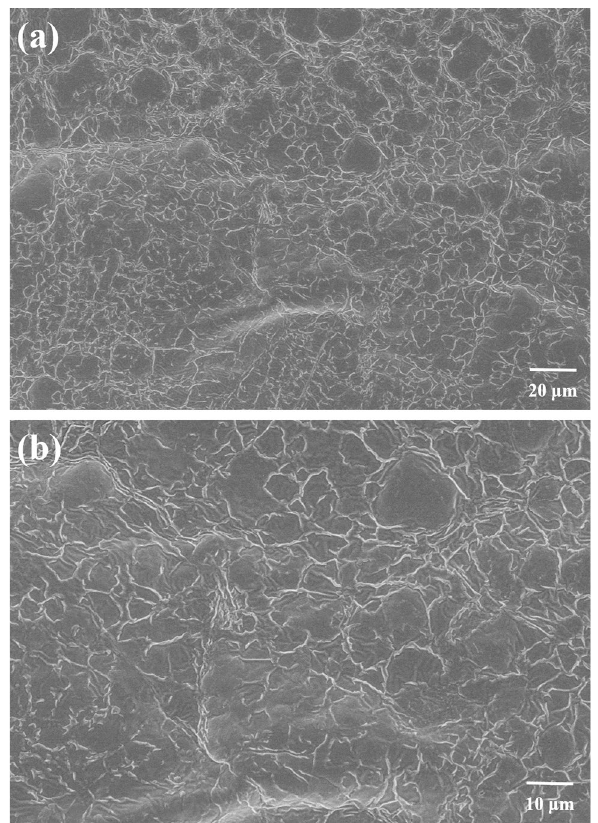
Figure 3. SEM images of PLY-F with different magnification ( a 5000, b